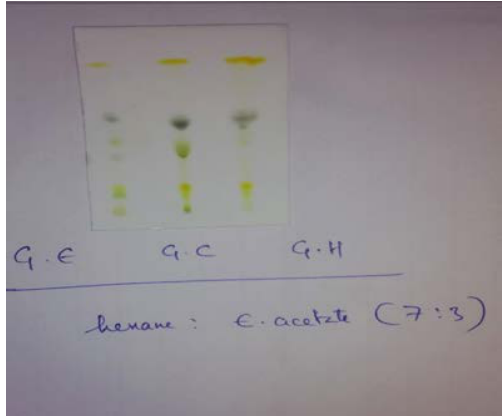
Fig. 1. TLC profile of the ethanol and chloroform extract of P. guajava leaf. Solvent system: Hexane : Ethyl acetate (7: 3). Table 1. + indicates presence of constituent (positive), - indicates absence of constituent (negative). Extracts Phenols Tannins Terpenoids